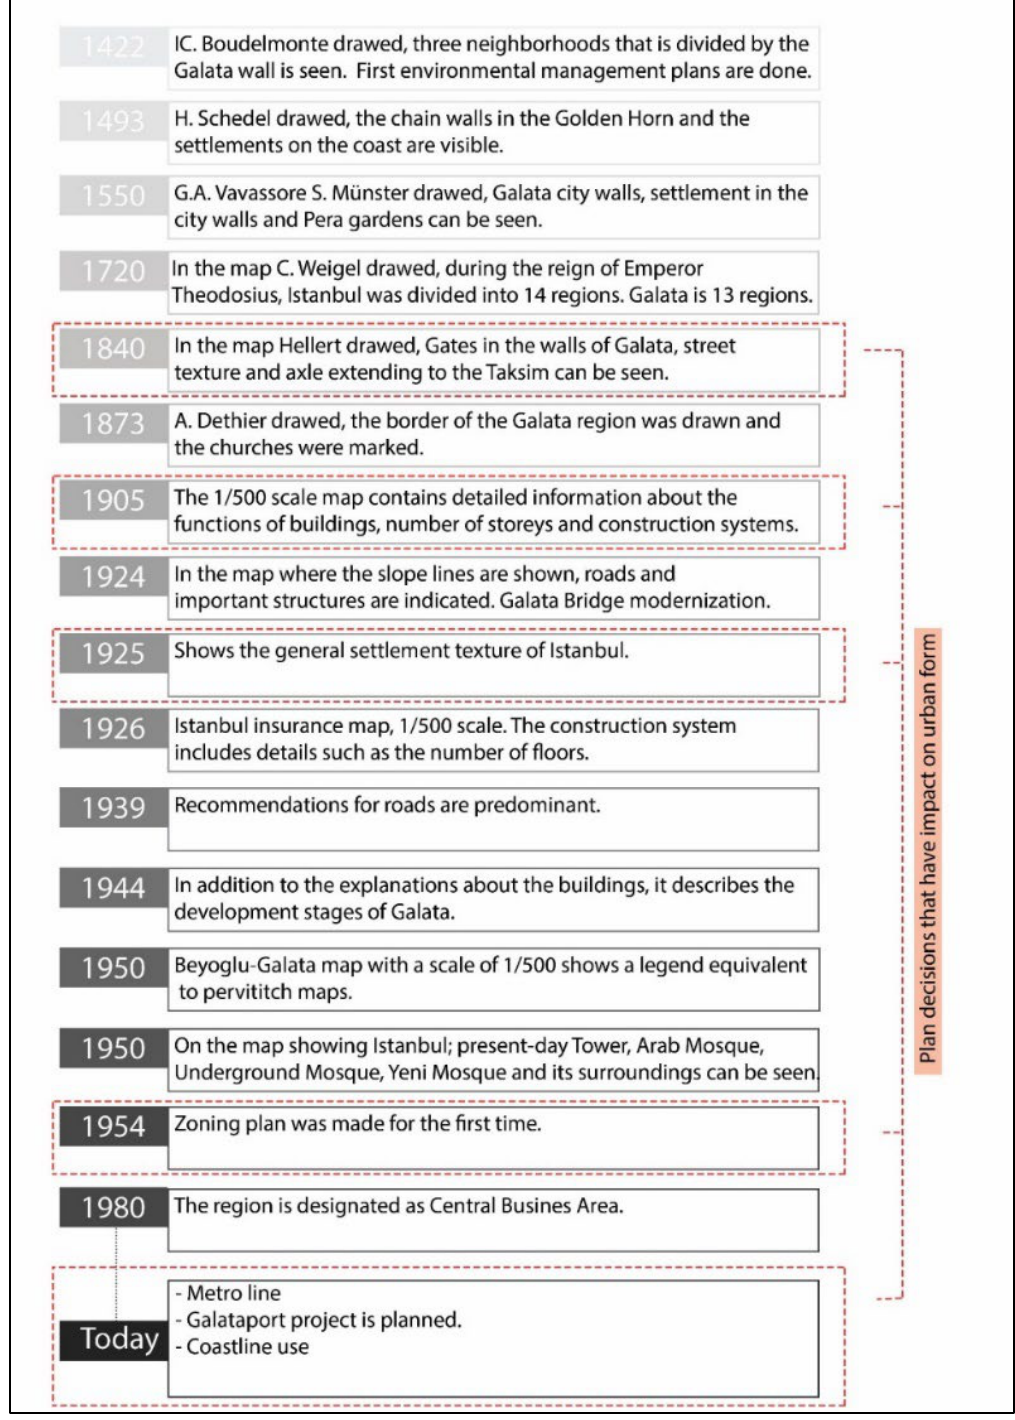
Figure 6 Major developments in the historical process of the Galata region, compiled by the